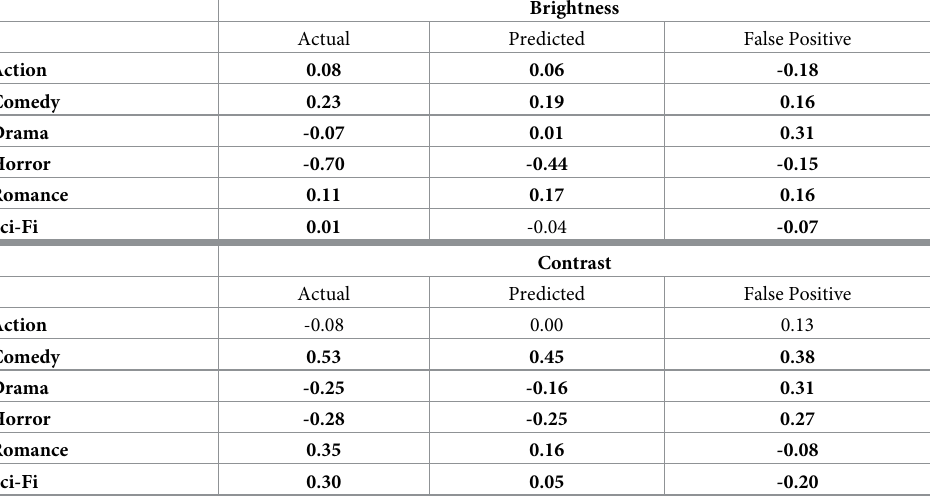
Table 5. Difference in median brightness and contrast ( × 10 1 ) across all films labeled with a given genre against median brightness and contrast of the set of films excluding the given genre. Bold values show a statistically signifi- cant difference, as given by a Mann-Whitney U test with Bonferroni correction ( α = 0.01, m = 6) between the median of films including a given genre against those excluding it, within a given prediction source (Actual, Predicted, or False